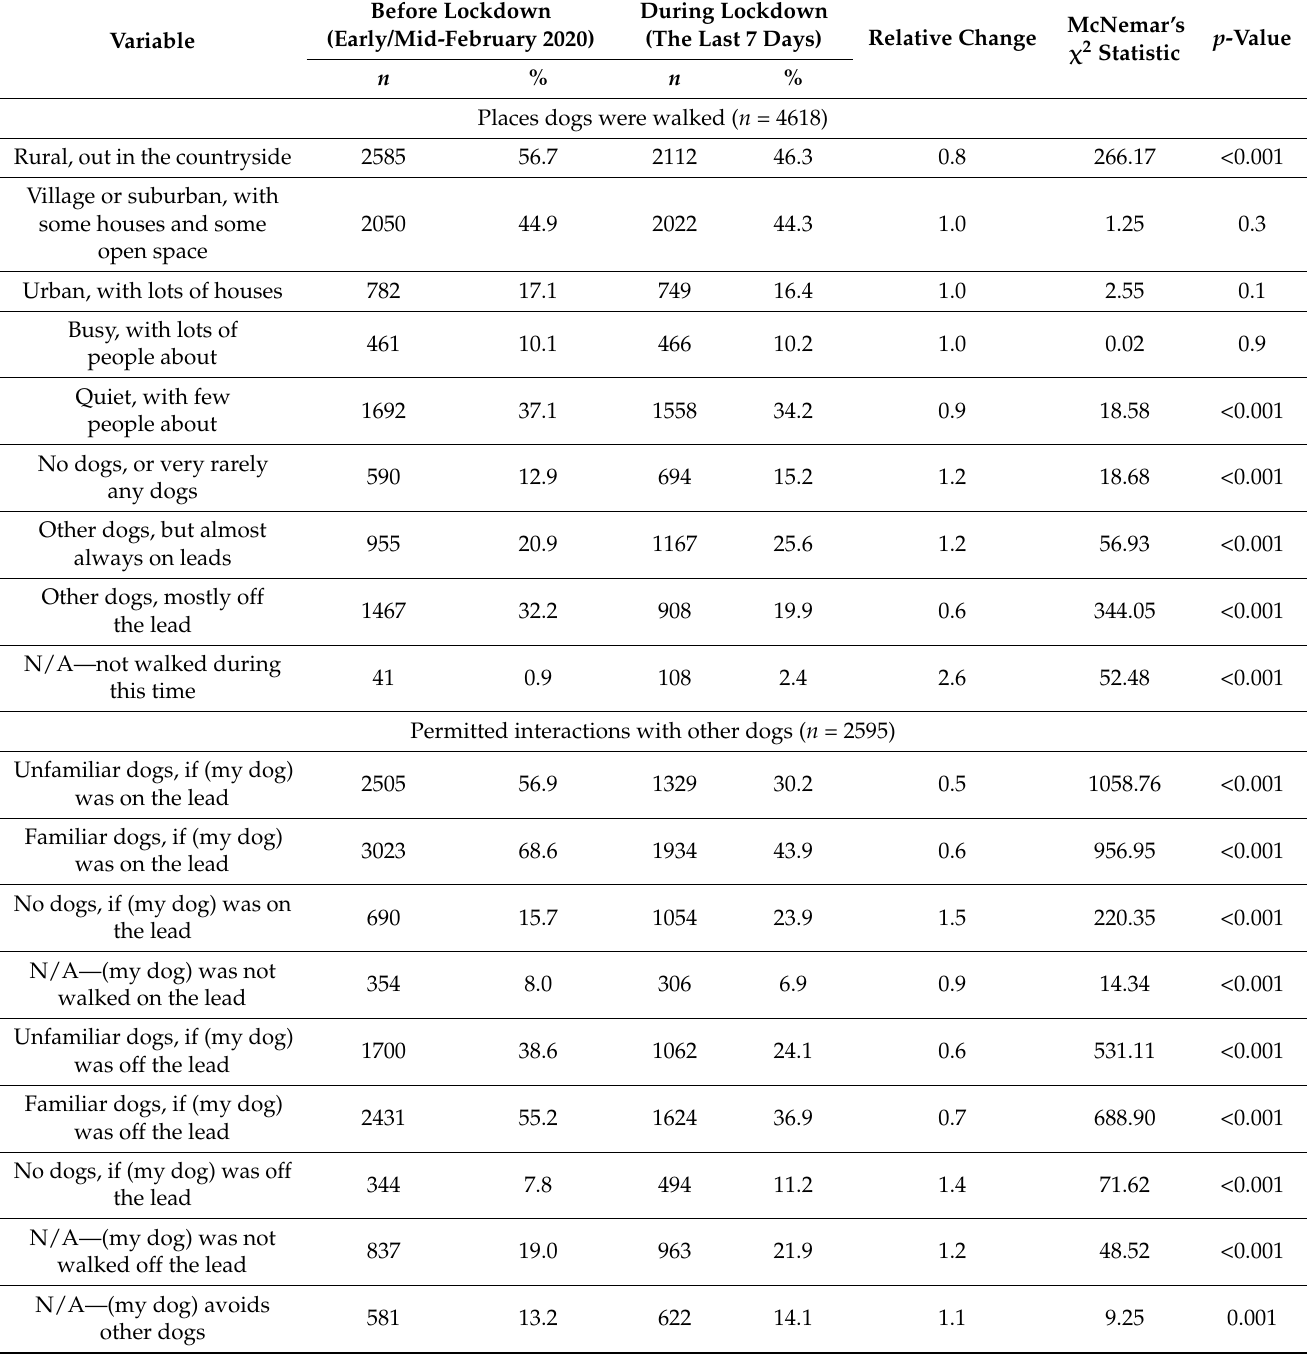
Table 5. Comparison of owner-reported selection of walking locations and degree of permitted interactions with other dogs while on walks between periods before and during